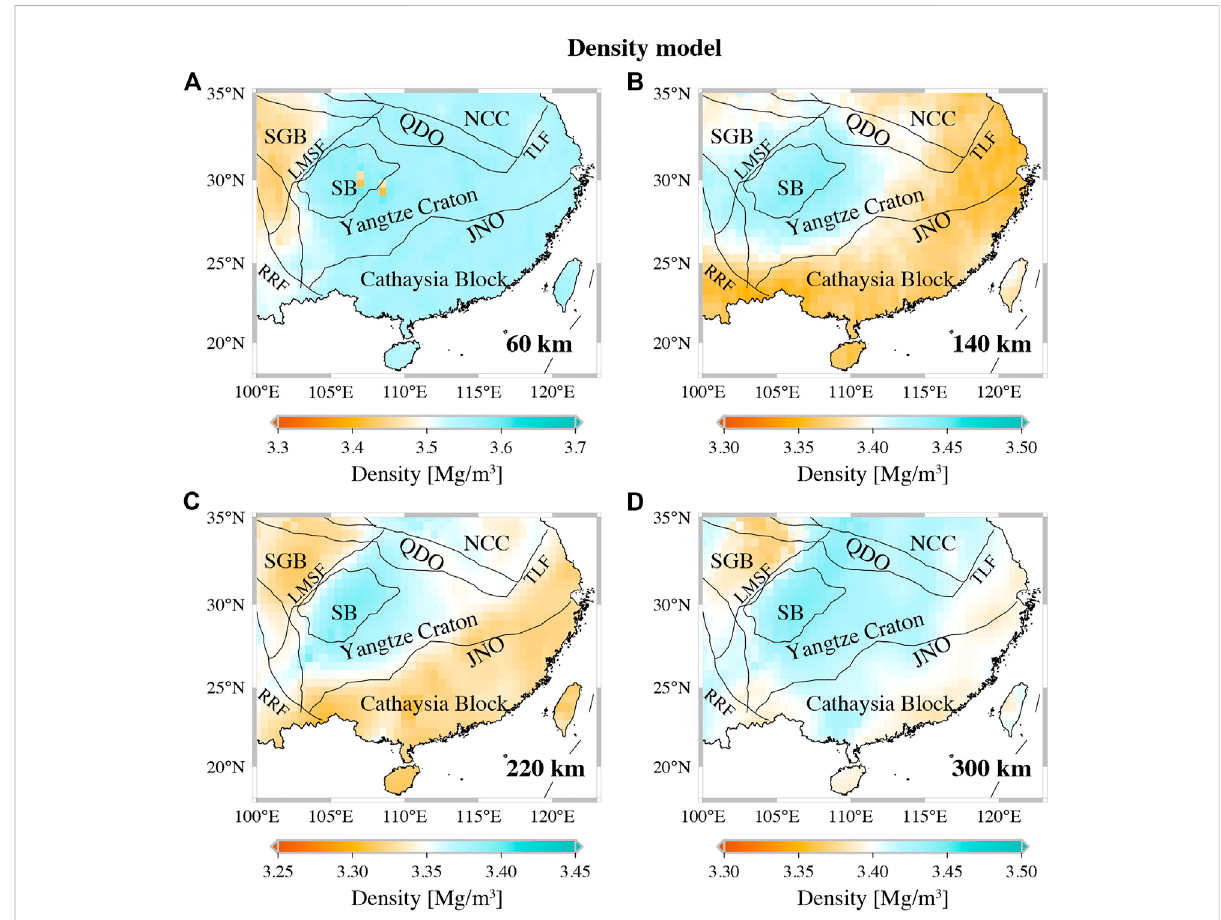
FIGURE 11 The density distribution of the mantle component of SREM-SC at depths of (A) 60 km (B) 140 km (C) 220 km, and (D) 300 km, calculated from the empirical relationship proposed by Kennett et al. (2013) between the density and shear wave velocity. The solid black lines in (A) denote the location of cross-sections in Figure 12, Figure